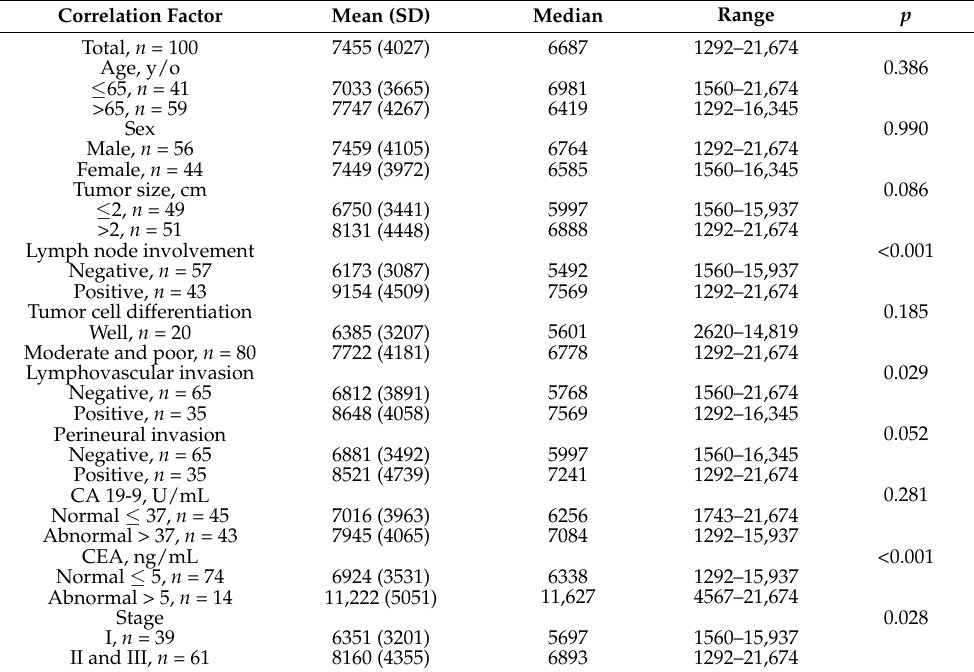
Table 1. Circulating cell-free DNA in ampullary cancer patients undergoing pancreaticoduodenectomy.